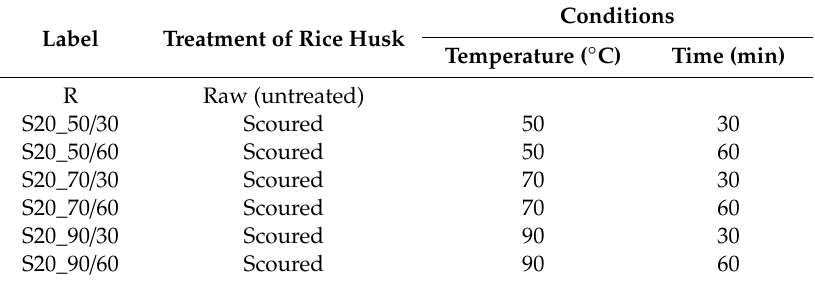
Table 2. Sample label and summary of alkaline scoured rice husk treated with 20 g/L sodium hydroxide under different temperature and treatment time.